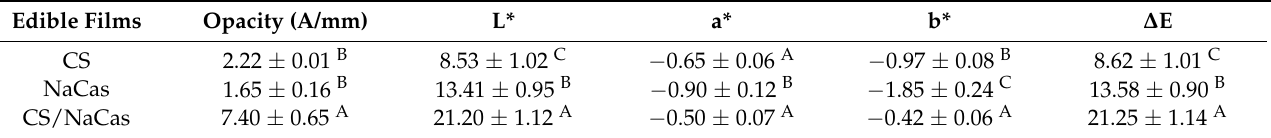
Table 2. Opacity and color parameters of chitosan and sodium caseinate edible